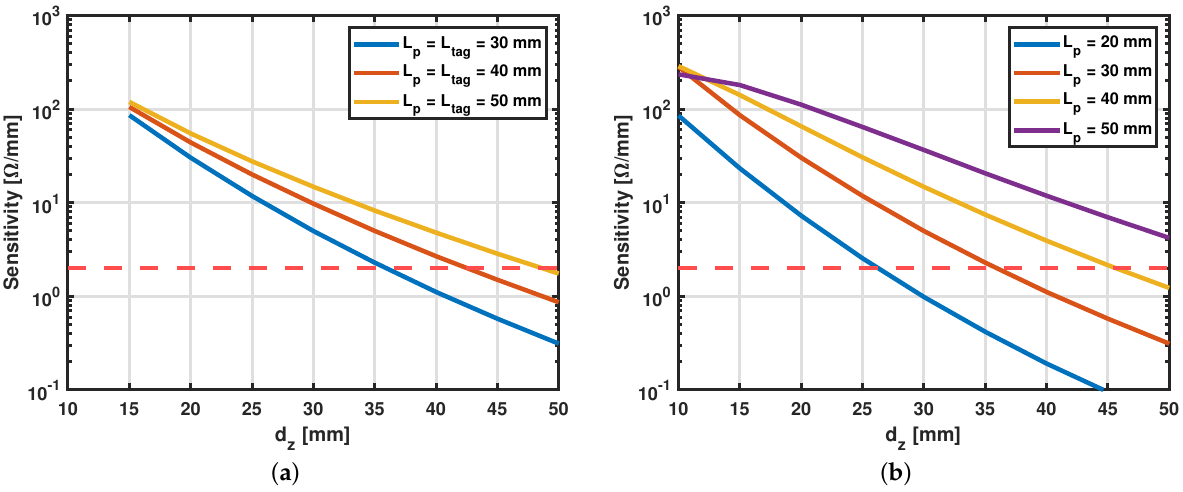
Figure 3. ( a ) Sensitivity vs. normal distance for different sizes of the sensor while keeping the side length of the probe and the SR equal. ( b ) Sensitivity vs. normal distance while varying the probe dimensions for a constant side length of the SR, L tag = 30 mm. The dashed red lines represent a threshold sensitivity of 2 Ω